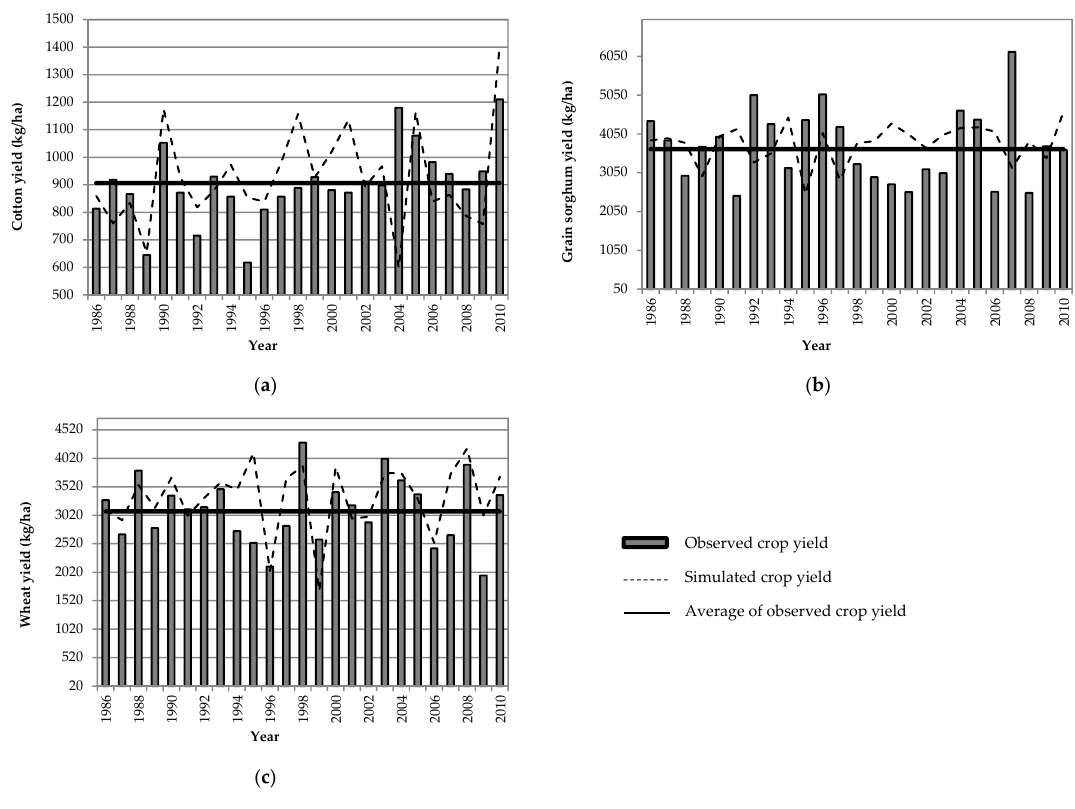
Figure 4. Observed and simulated average annual yields of ( a ) cotton, ( b ) grain sorghum, and ( c ) winter wheat in the study area.